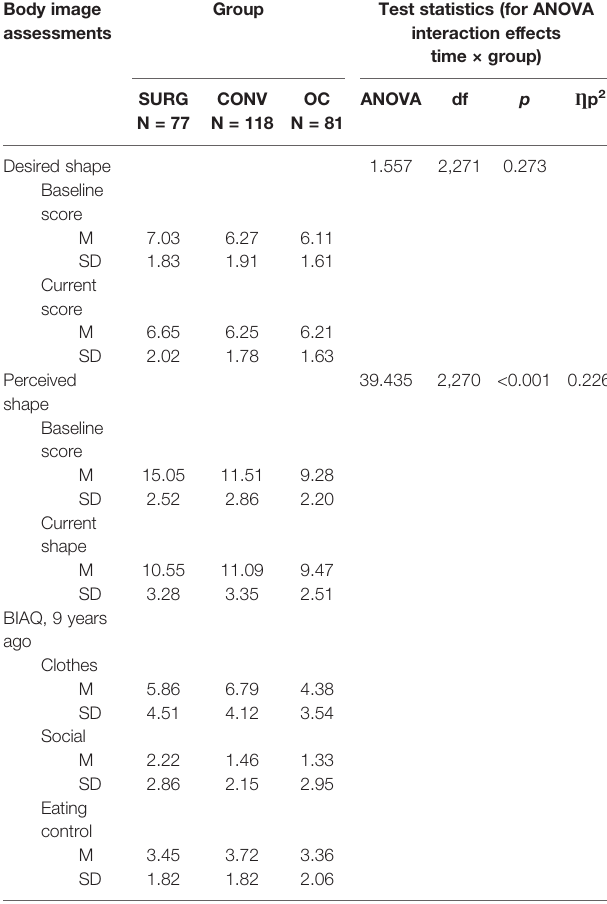
TABLE 3 | Mean Scores and standard deviation for body image-related